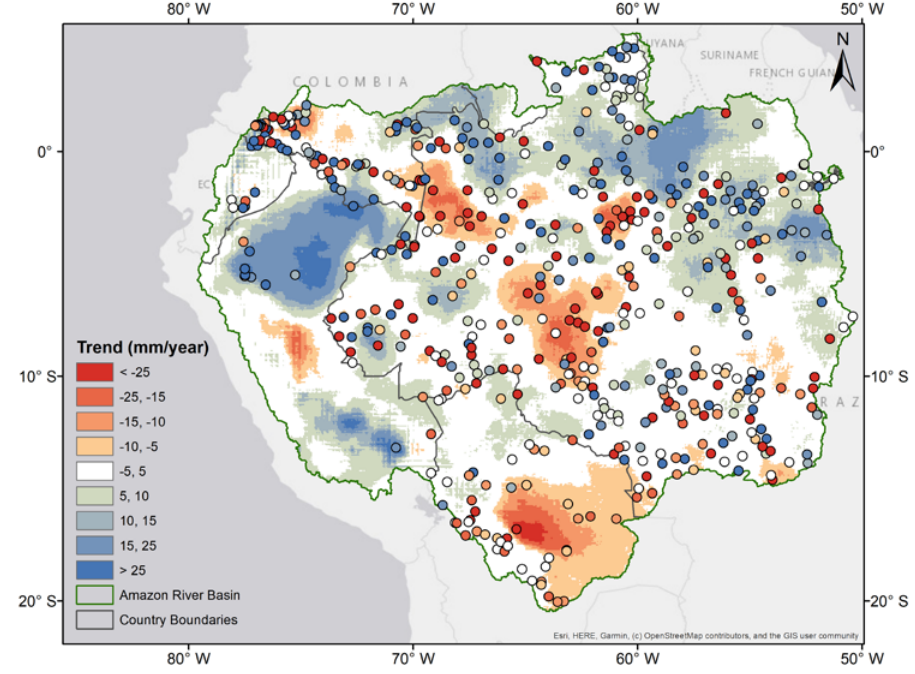
Figure 5. CHIRPS variation and trends from the in-situ precipitation stations.